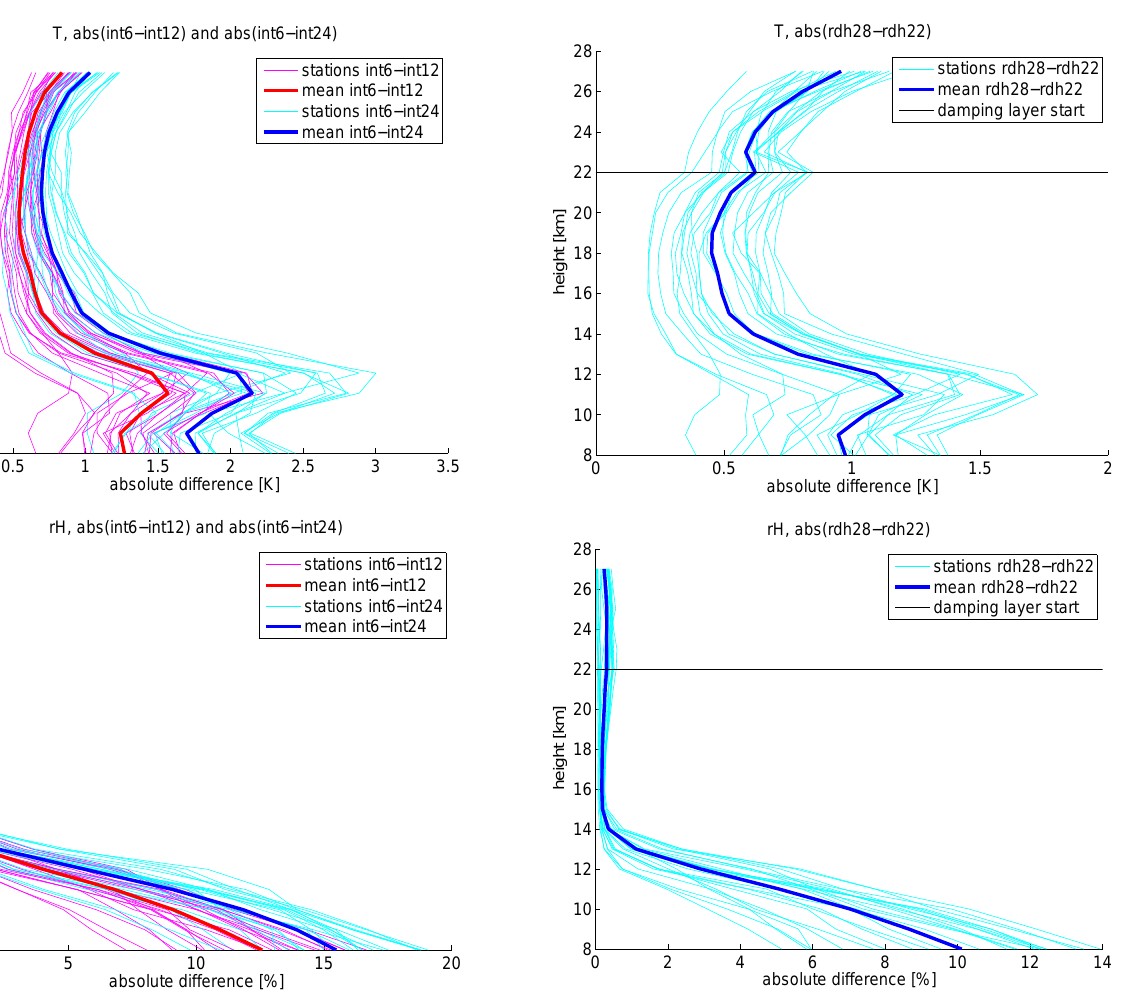
Figure 17. Difference between the model runs with 12 and 24- hourly forcing to the original run with 6-hourly forcing for T (top) and RH (bottom). Shown is one profile for each station and the mean of all stations.